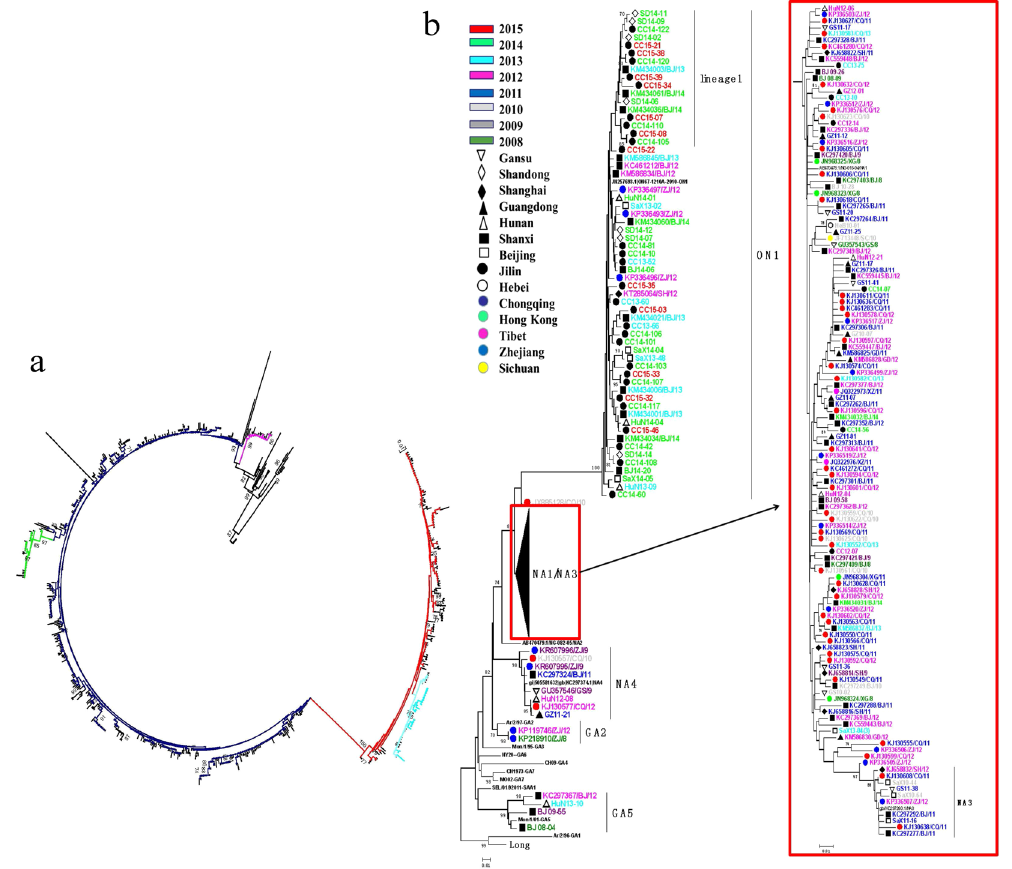
Figure 1. ( a ) Phylogenetic tree of HRSVA sequences from 14 provinces in China between January 2008 and February 2015. The branch of the ON1 genotype is colored in red, lineage 1 is colored in light fluorescence blue, the NA3 genotype is colored in green, the NA4 genotype is colored in purple, and the NA1 genotype is colored in navy. ( b ) Phylogenetic tree of representative HRSVA sequences obtained from January 2008 to February 2015 in China. Representative sequences were chosen from those with the pairwise distances > 0.025. Years of sample collection are indicated by the colors of the sequence names, and the locations of sample collection are indicated by the symbols according to the